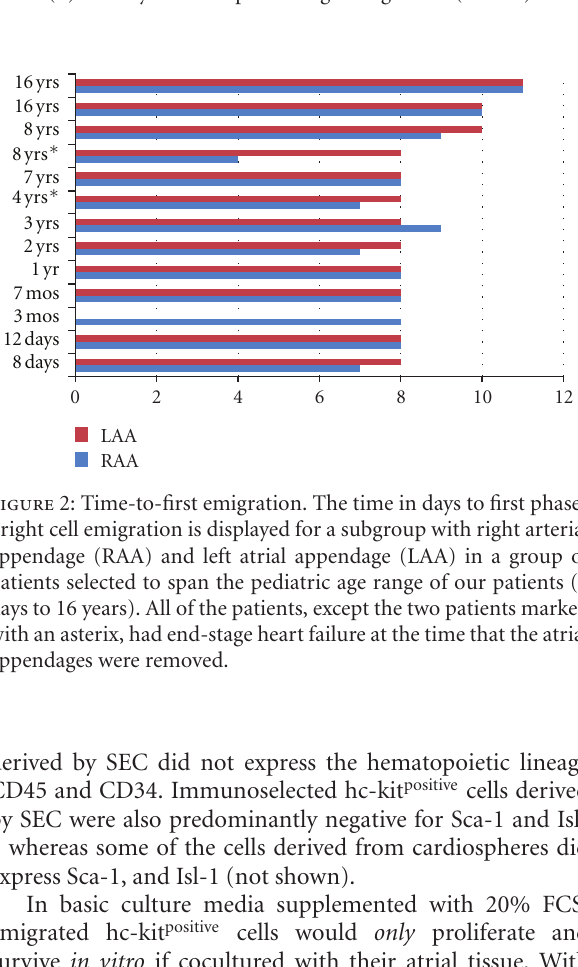
Figure 1: Representative phase contrast photomicrographs of cell emigration and proliferation with SEC. (a) Spontaneous emigration of phase-bright cells (green arrow) “budding” or emerging from the cut surface of suspended atrial tissues at Day 7 of SEC. Magnification × 400. (b) Loosely attached phase-bright single cells (arrows) and cellular aggregates (box) at Day 21 in SEC. Magnification × 250.